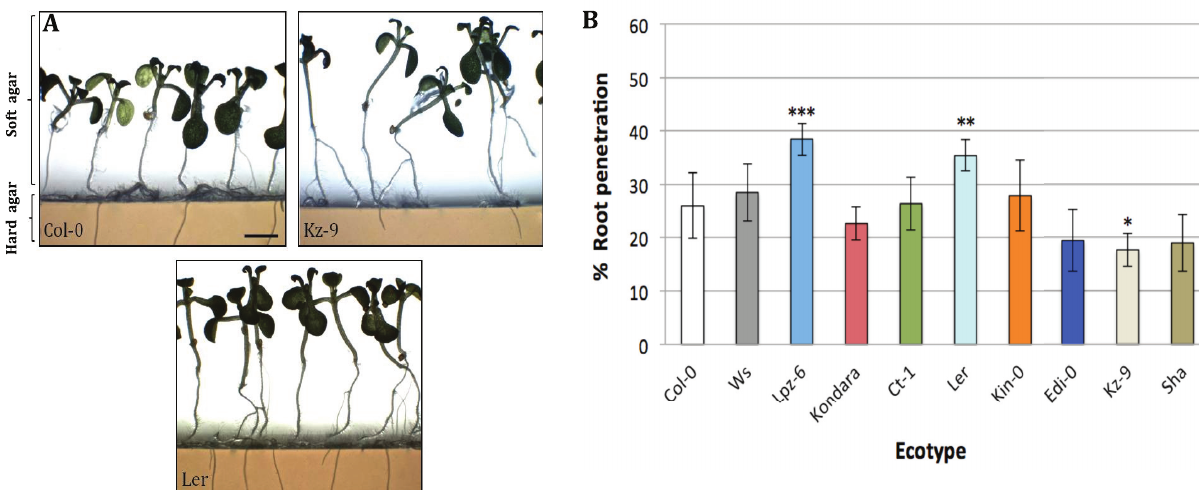
Figure 2. Natural variation of Arabidopsis ecotypes in root penetration ability. A ) Col-0, Kz-9 and Ler Arabidopsis ecotypes show a wide variation in penetrating hard agar layers. Screening test was carried out using a double-phase agar system, which mimics soil compaction condition. B ) Quantitative analysis of the root penetration ability expressed as the root penetration percentage (%) in reference to that of Col-0, showed by nine different Arabidopsis ecotypes. (*) indicates statistically significant differences: * P <0.05, ** P <0.01, and *** P <0.001 level; n=120 seedlings per ecotype (one-way